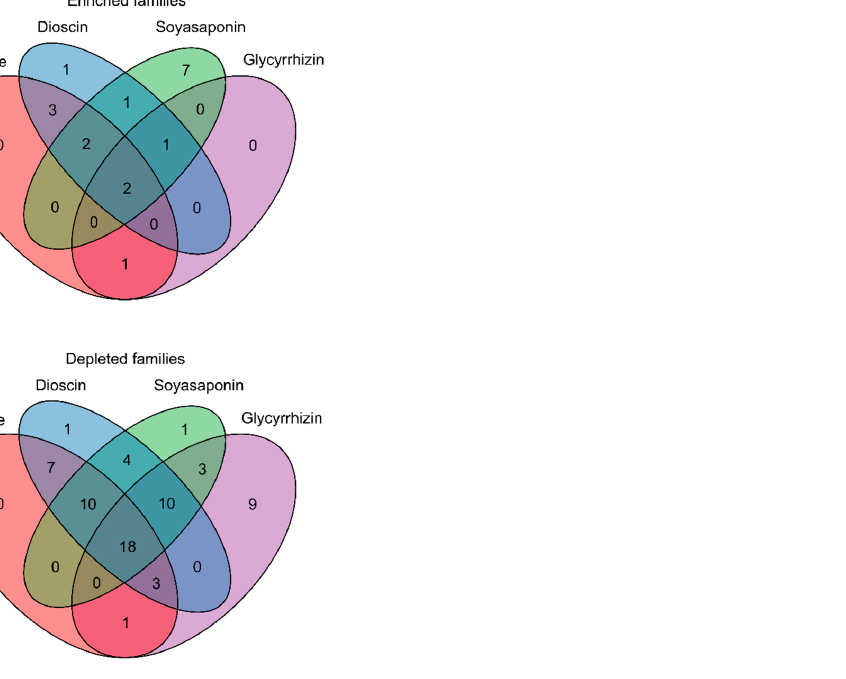
Figure 4. Venn diagrams to illustrate the overlap of the significantly enriched or depleted bacterial families in the soils treated with saponins, 250 nmol (high concentration) g soil − 1 compared with untreated soils using LEfSe method (an adjusted p -value < 0.05). The numbers of bacterial families are shown in the ellipses.